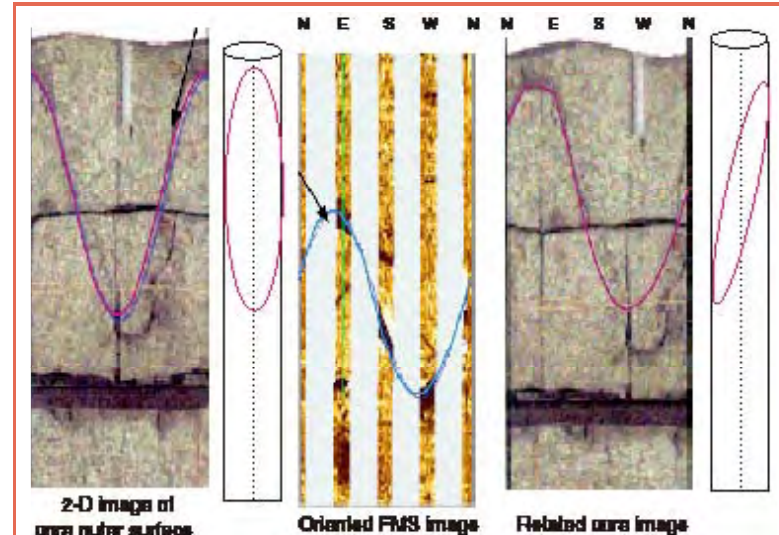
Figure 3. Reorientation of core from ODP Leg 176 using correlation with a fracture imaged by the Formation MicroScanner (FMS) electrical resistivity image tool (Modified from Haggas et al.,